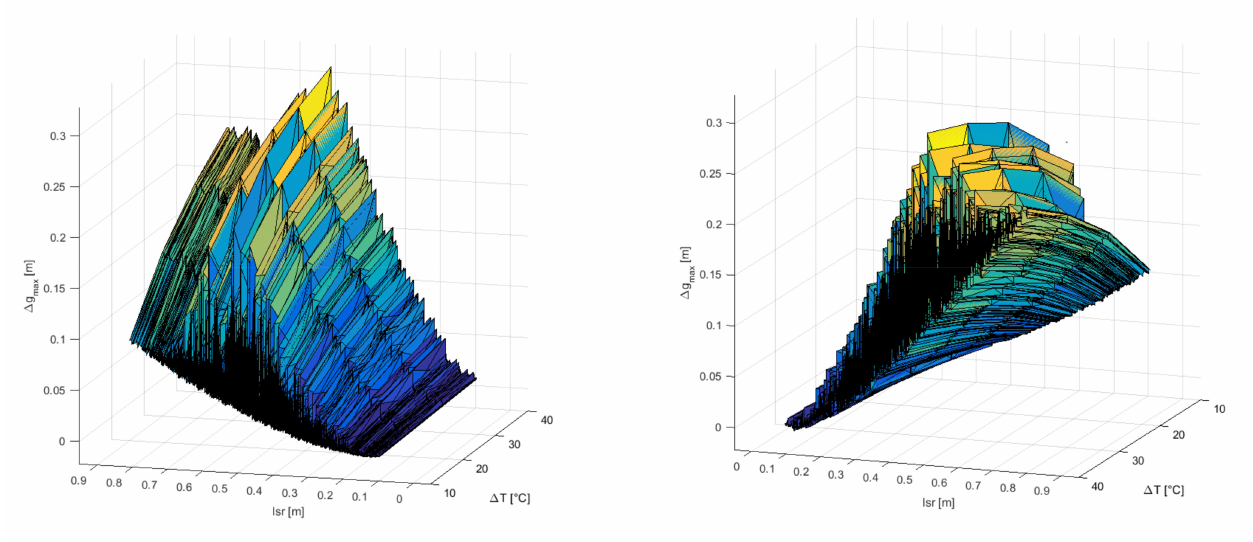
Figure 6. Maximum change in the result for detecting the location of PD ∆ g max over the mean distance between PD and AE sensor l sr and temperature change ∆ T , in the first simulation.